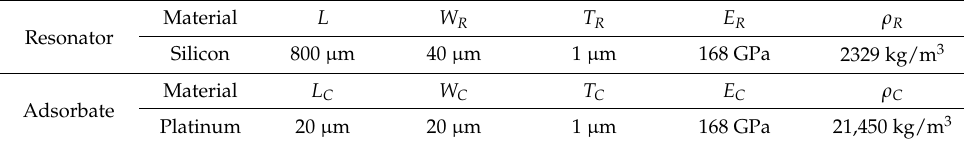
Table 3. The parameters of the silicon cantilever resonator and platinum